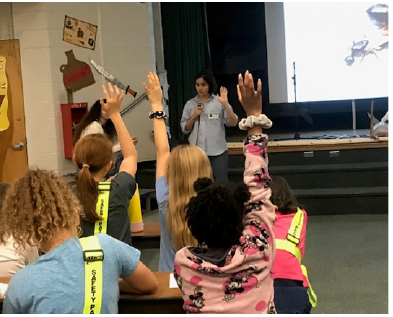
Figure 1. Fifth graders asking questions about ants. Picture by M.S.